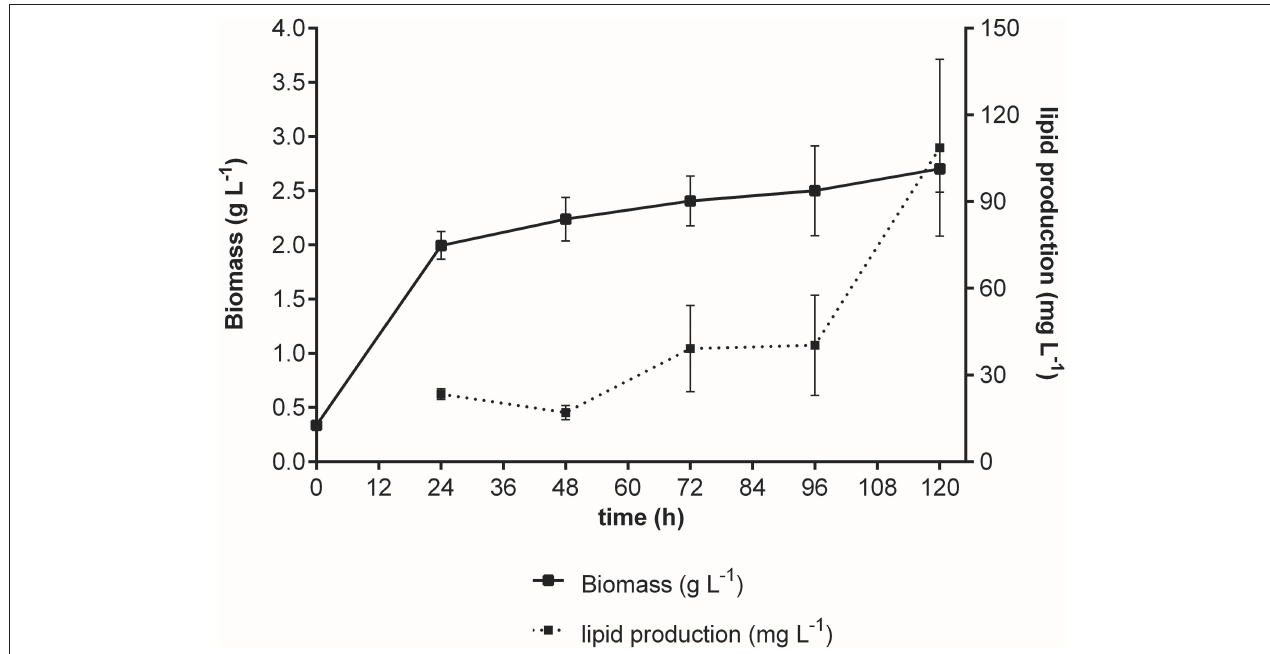
FIGURE 2 | Growth curve of M. guilliermondii BI281A using glucose as carbon source. The solid line represents dry biomass (g/L) and the dotted line represents the lipid production (mg/L). All experiments were done in biological triplicate.